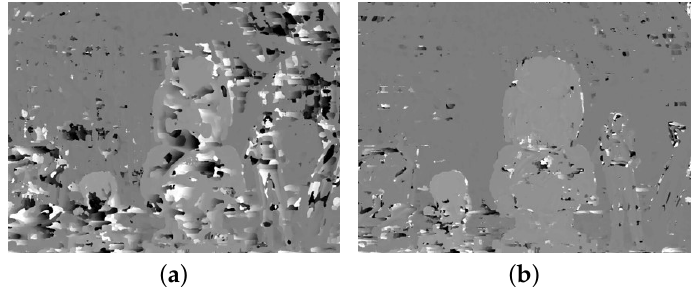
Figure 5. Poor disparity estimation results of a DCA image using the traditional method: ( a , b ) are matching results using sum of absolute differences (SAD) and normalized cross-correlation (NCC), respectively.